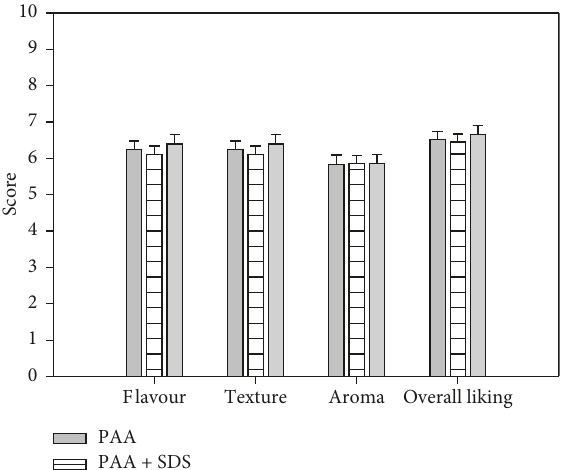
Figure 6: Panel test scores for baby spinach treated with per- oxyacetic acid (PAA) and peroxyacetic acid +sodium dodecyl sulphate (PAA +SDS), stored at 4 ° C for 48–64h. Error bars rep- resent the standard error of the mean ( n � 30–34